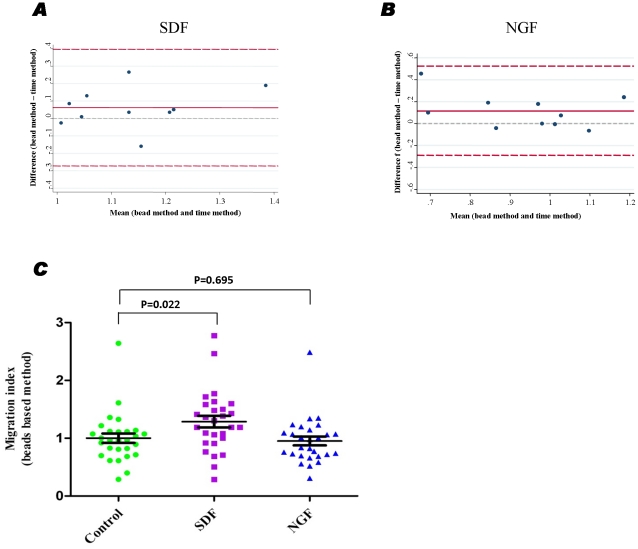
Migration capacity of isolated leukocytes assessed using time of acquisition by FACS and counting beads.Blood was collected at TP2 (84–108 h) post-MI and subjected to Histopaque-1077 density gradient centrifugation. The buffy coat was collected and washed in PBS. Cells were suspended in EBM-2 medium at a density of 0.5–1×107 cells/mL and loaded on 6-well tissue culture inserts (3-µm pore ThinCert; Greiner Bio One). Medium with or without chemoattractants (i.e. SDF or NGF) was added in the bottom part of the inserts. Following transwell migration in a humidified CO2 incubator for 18 hrs, the migrated and non-migrated cells number was evaluated by FACS analysis with the assistance of acquisition time or counting beads. As described in
Materials and Methods
, migration index (ratio of migrated cell fraction in the total cells) of each sample was then estimated using both the acquisition time-based and beads-based approaches (A and B). Migration index evaluated in the presence of counting beads (C).